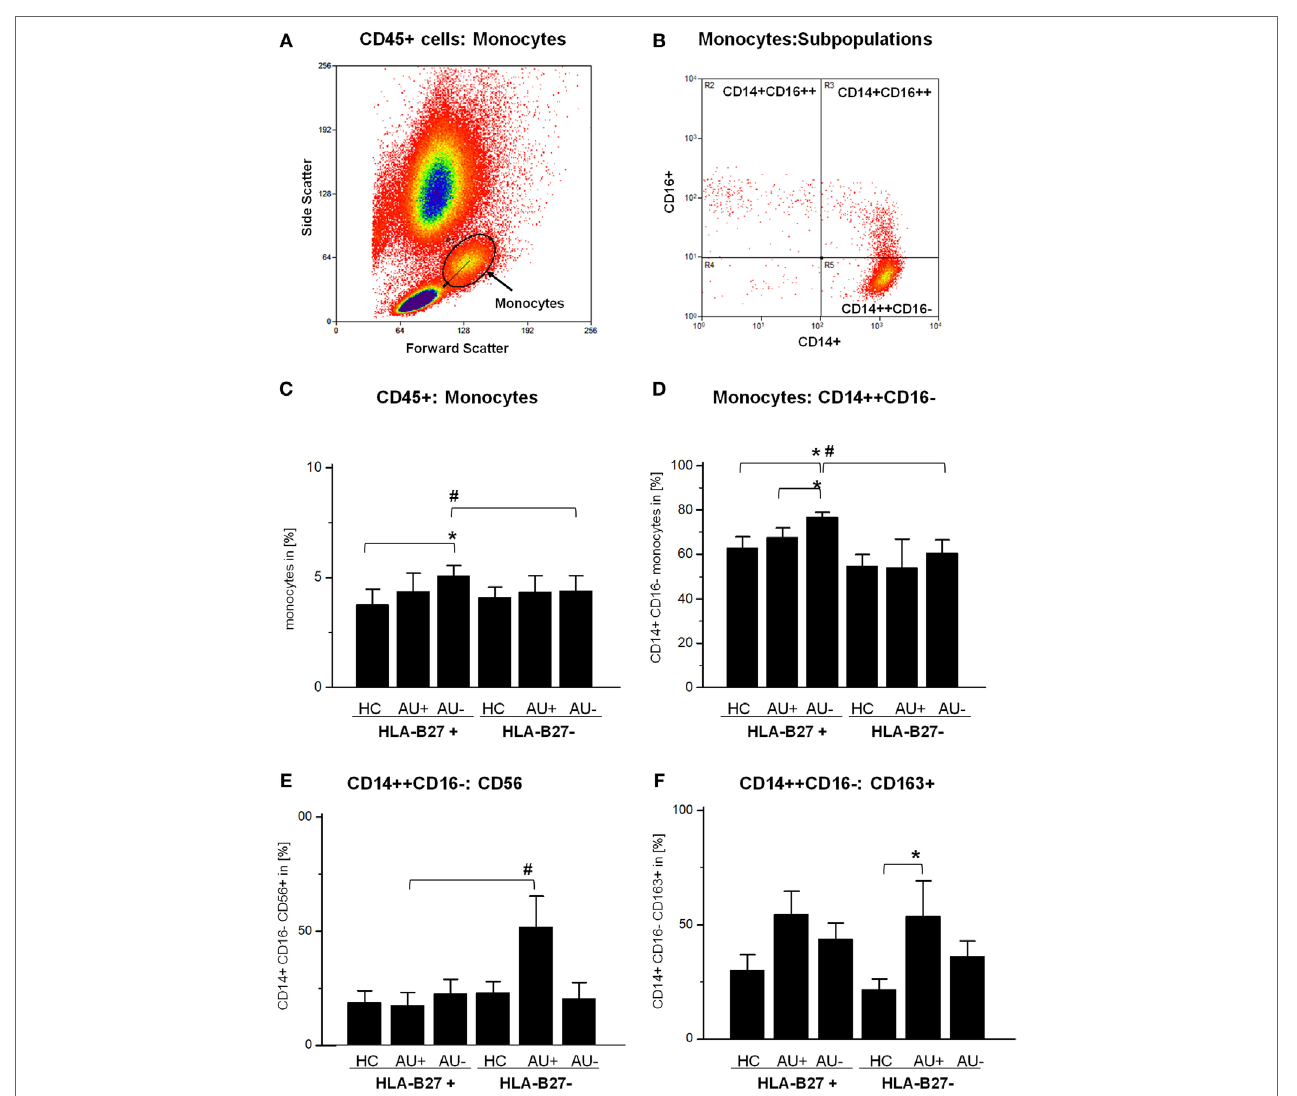
FigUre 1 | Flow cytometry analysis of CD45 + whole blood cells: (a) identification of monocytes in forward and side scatter plot (FSC/SSC) and (B) further differentiation by CD14 and CD16 expression into classical (CD14 ++ CD16 − ), intermediate (CD14 ++ CD16 + ), and non-classical (CD14 + CD16 ++ ) monocytes. Frequency of (c) monocytes (FSC/SSC), (D) CD14 ++ CD16 − classical monocytes, (e) CD14 + CD16 − :CD56 + monocytes, and (F) CD14 + CD16 − :CD163 + monocytes in peripheral blood of HLA-B27-positive/-negative healthy controls (HCs), and patients with active (AU + ) and inactive (AU − ) anterior uveitis (* p < 0.05; Kruskal–Wallis test; # p < 0.05; Mann–Whitney U